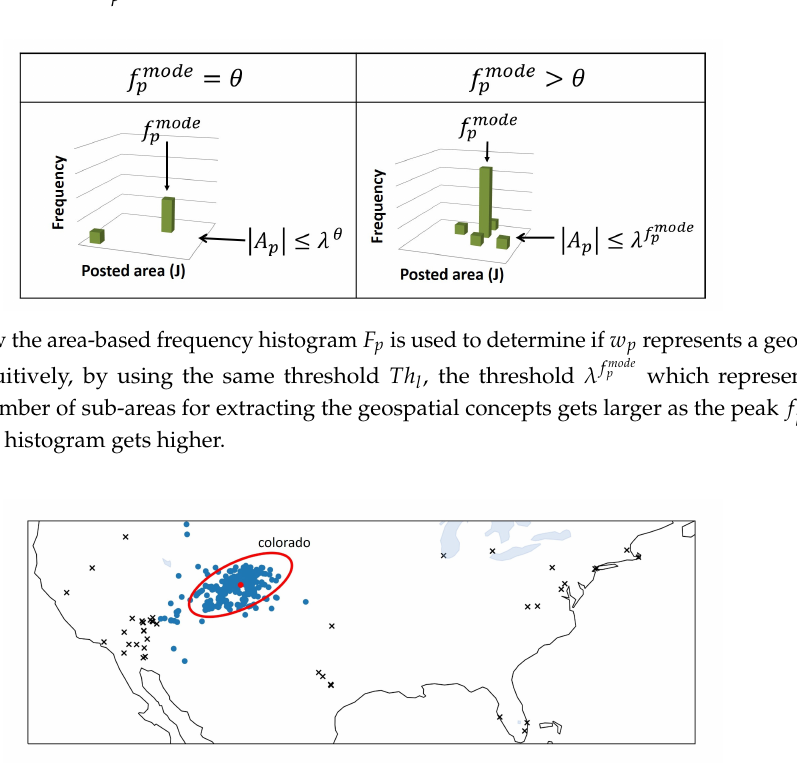
Figure 3. How geospatial features of geospatial concepts are obtained by applying Mean Shift clustering to L p when w p = colorado . Cross marks represent the removed l n and blue marks represent the points l n forming a cluster. The red ellipse represents the 95% confidence interval based on the mean and covariance matrix of the bivariate normal distribution fitted to the blue